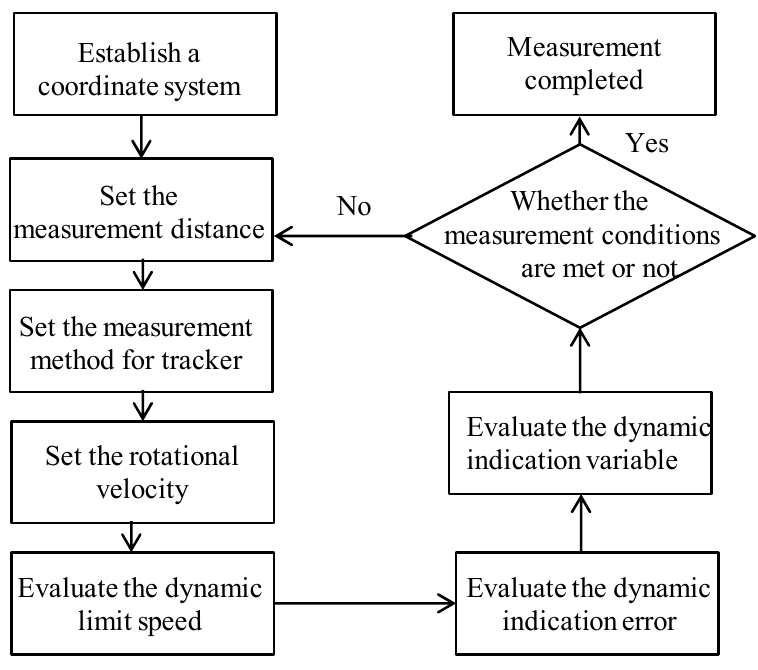
Figure 2. Flow chart of the measurement.